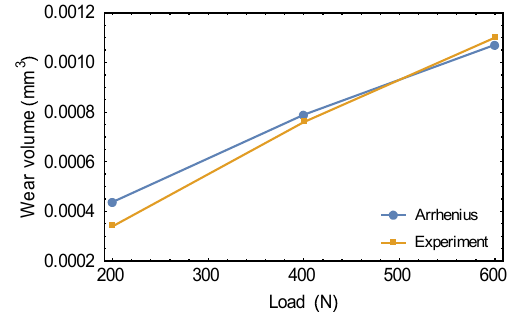
Fig. 14 Wear volume vs. load.